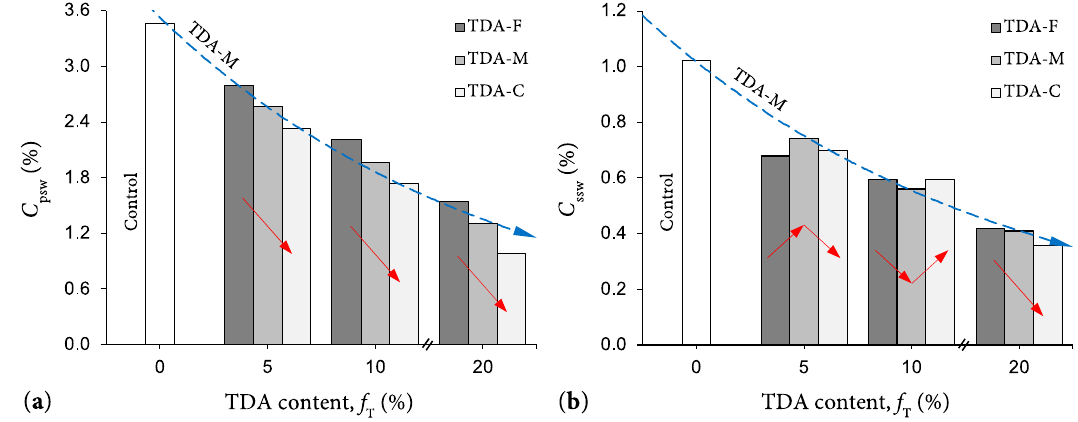
Figure 6. Variations of the ( a ) primary swelling and ( b ) secondary swelling coefficients (i.e., C psw and C ssw ) against TDA content f T for the tested mix